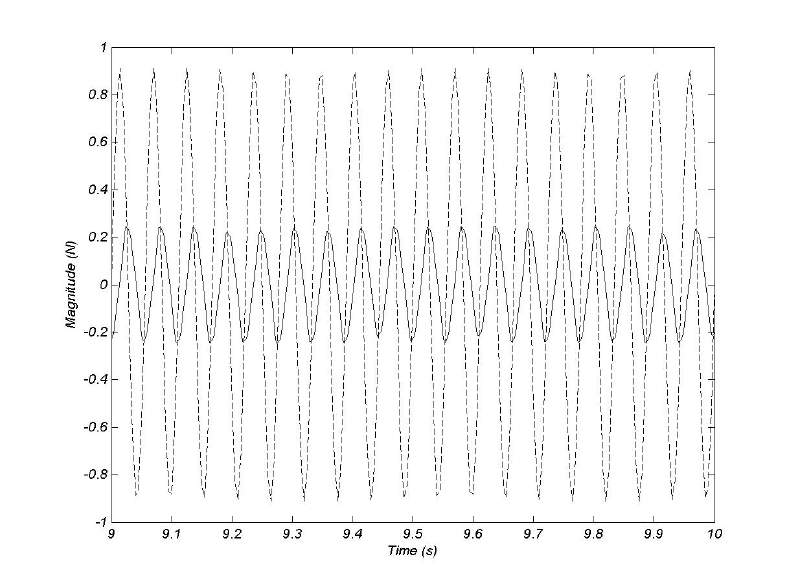
Fig. 23. Transmitted force variationsof the system using the PID controller subjected to periodic engine disturbance at idling frequency at the final 1 seconds of the simulation. Open loop (–) and PID controlled